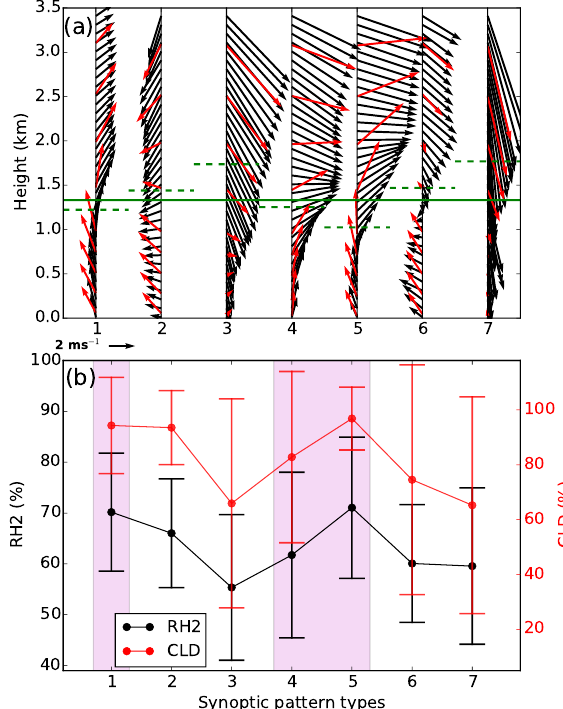
Figure 6. (a) Average wind vector profiles at 14:00BJT and (b) ob- served daily RH2 and CLD at 14:00BJT (mean ± 1 standard de- viation) associated with the seven types of synoptic pattern. In (a) , the wind vectors derived from soundings are denoted by black vec- tors and those from the NCEP-FNL reanalysis are in red. The green solid line shows the seasonal mean BLH and the dashed green lines represent the mean BLH for each synoptic pattern type. Note that the wind vector profiles from the NCEP-FNL reanalysis were de- rived by interpolating the values from the four nearest grids.